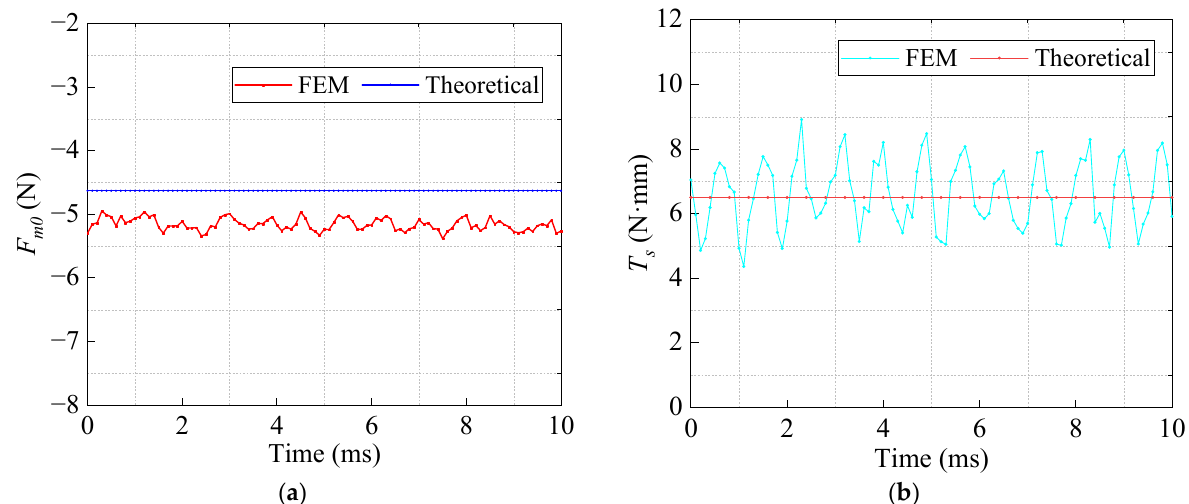
Figure 8. Variation curve of the electromagnetic torque and axial force during motor rotation: ( a ) Axial force of the bearingless motor; ( b ) Electromagnetic torque of the bearingless motor.